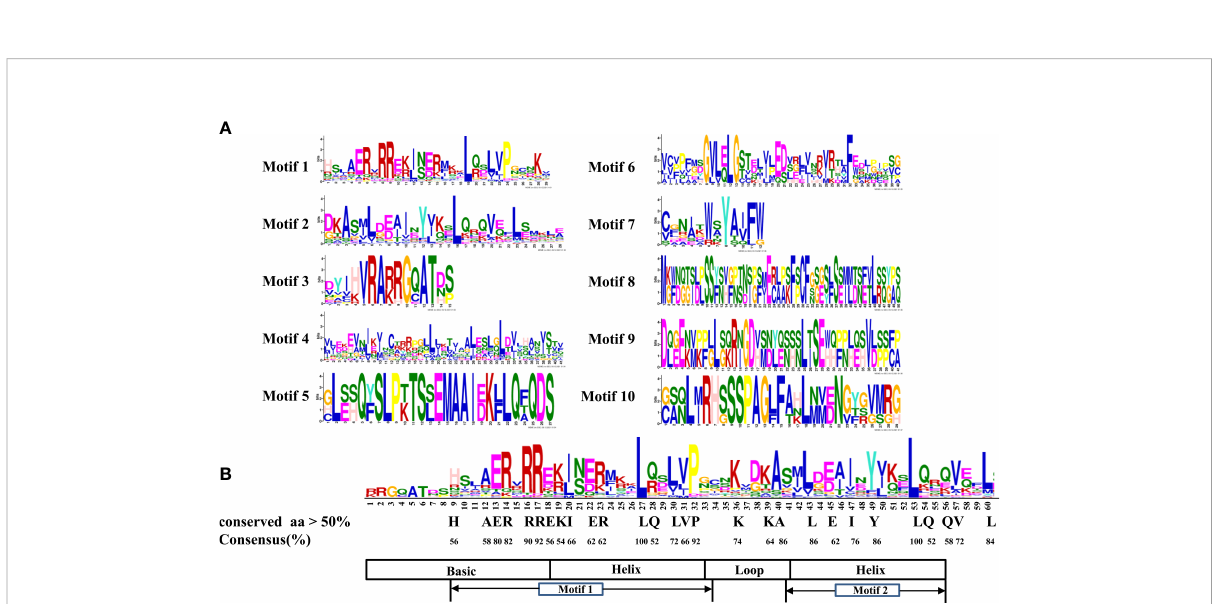
FIGURE 3 The conserved motifs analysis of LrbHLH proteins. (A) Conservation and diversity of the motifs in LrbHLH proteins. The schematic representation of ten motifs in LrbHLH proteins is elucidated by MEME; (B) LrbHLH proteins share a conserved bHLH domain. The amino acid height represents the sequence conservation. More than 50% amino acid conservation was presented with the capital letters, and the conserved amino acid percentages among bHLH domains are presented with numbers.